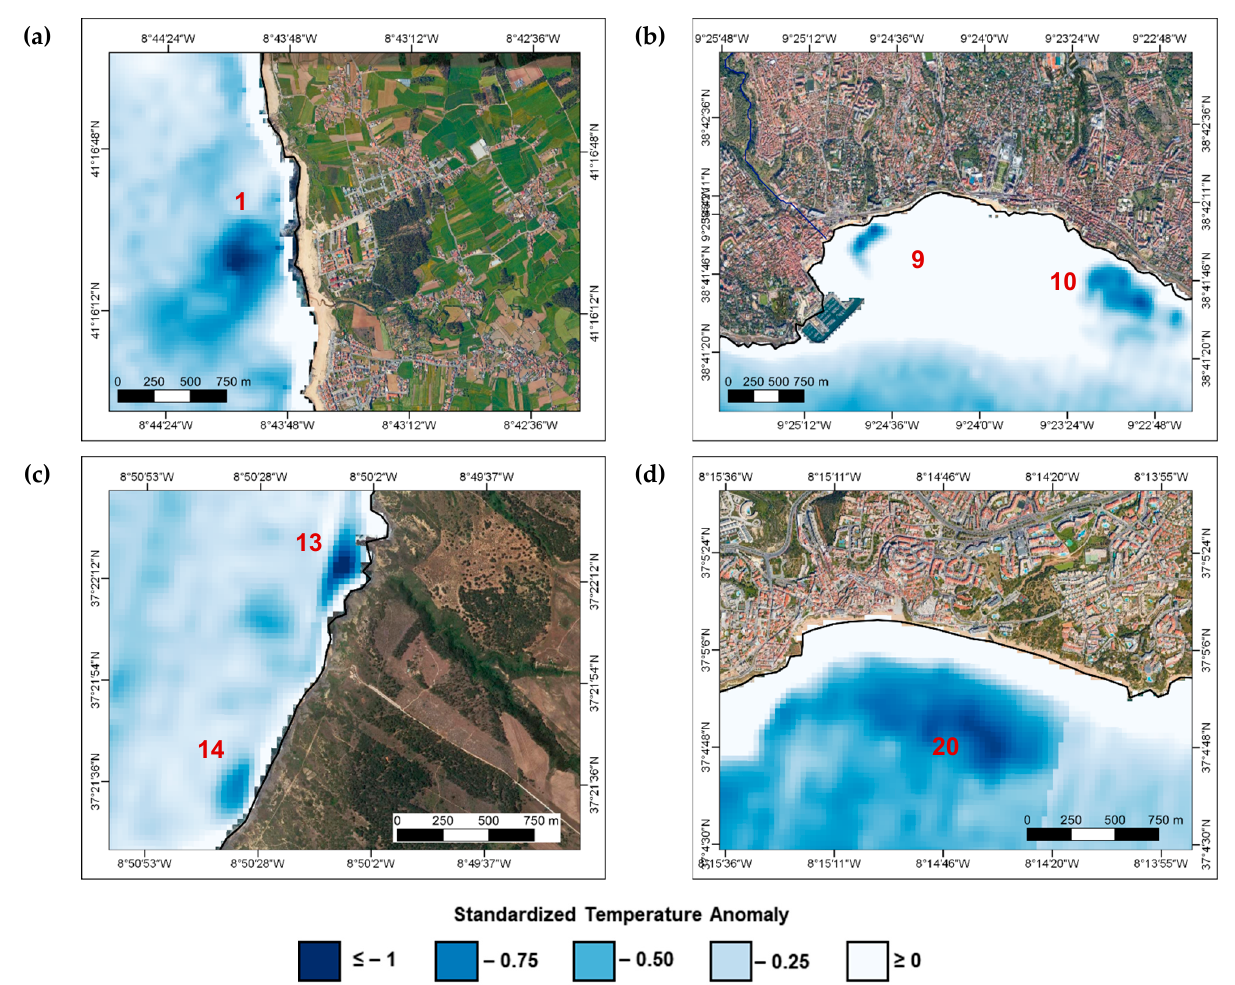
Figure 7. Standardized Temperature Anomaly maps and potential SGD sites in ( a ) Praia de Labruge (1) in the North, ( b ) Baía de Cascais (9) and Sao Joao de Estoril (10) in the Center region, ( c ) Praia de Carriagem (13) and Praia de Amoreira (14) in the Southwest coast, and ( d ) Albufeira (20) in the South coast of Portugal. Table 4. Location of coastal springs identified in situ during the fieldwork reconnaissance campaign in the South and Southwest coast of